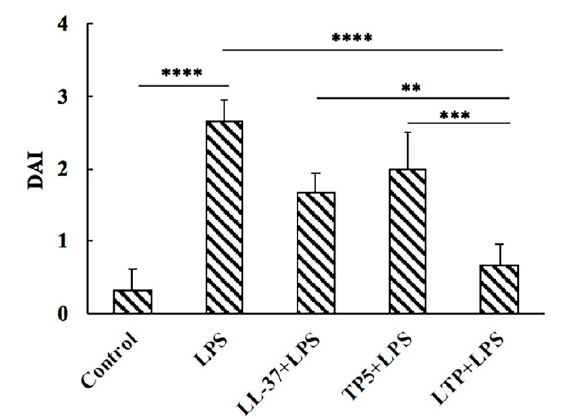
Figure 3. LTP improved disease activity index (DAI). Different peptides (10 mg/kg) were injected into the mice once daily for 6 days, whereas the control and LPS-treated groups were injected with an equal volume of sterile saline. On day 6, mice in the LPS and peptide-pretreated groups were injected with LPS (10 mg/kg) 1 h after the peptide or saline treatment. The control group was injected with an equal volume of saline. The body weights and DAI of the mice were recorded before and after the experiment. Data are given as the mean value ± standard error from 12 biological replicates. **: p ≤ 0.01, ***: p ≤ 0.001, ****: p ≤ 0.0001.